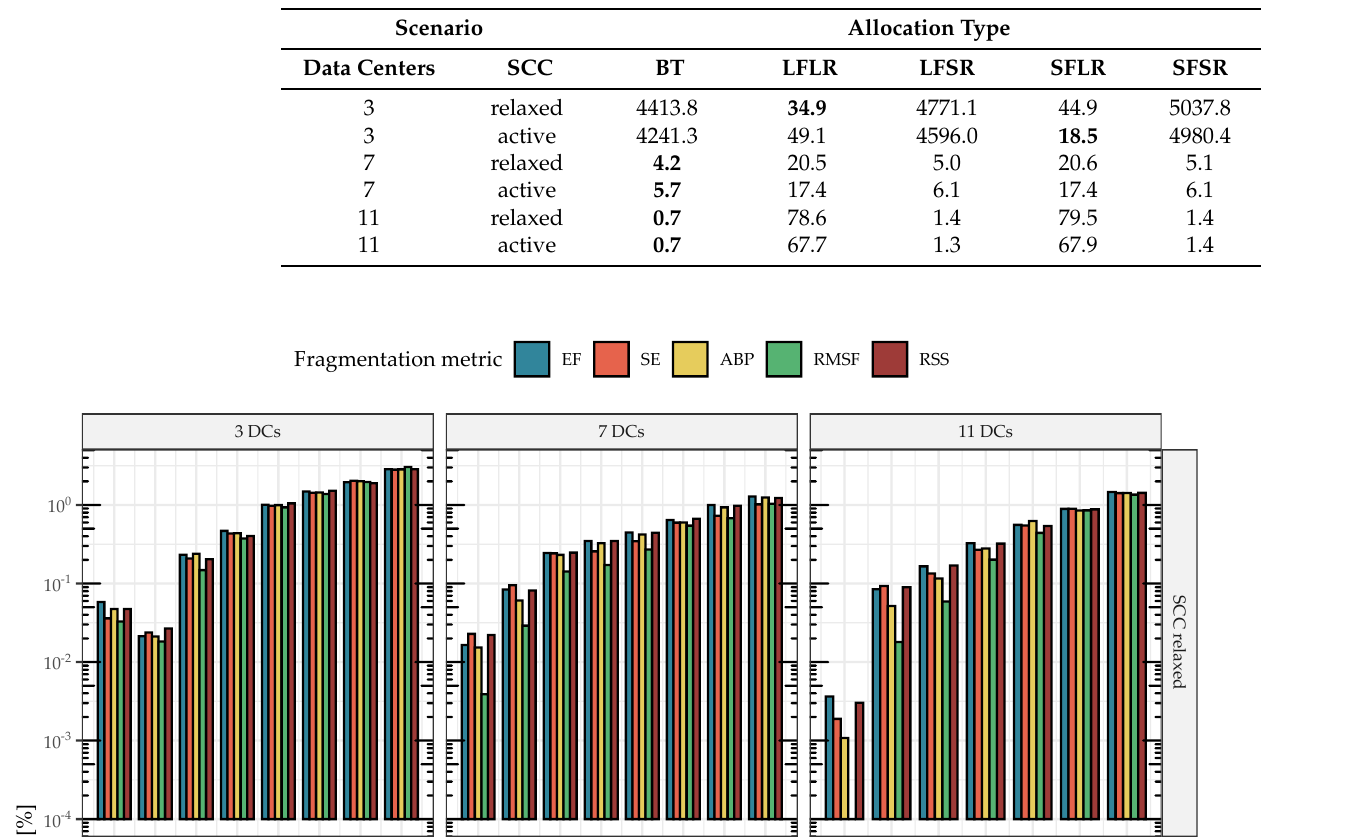
Table 3. Average percentage and minimum result for various allocation strategies for the first fit and k-first fit algorithms.